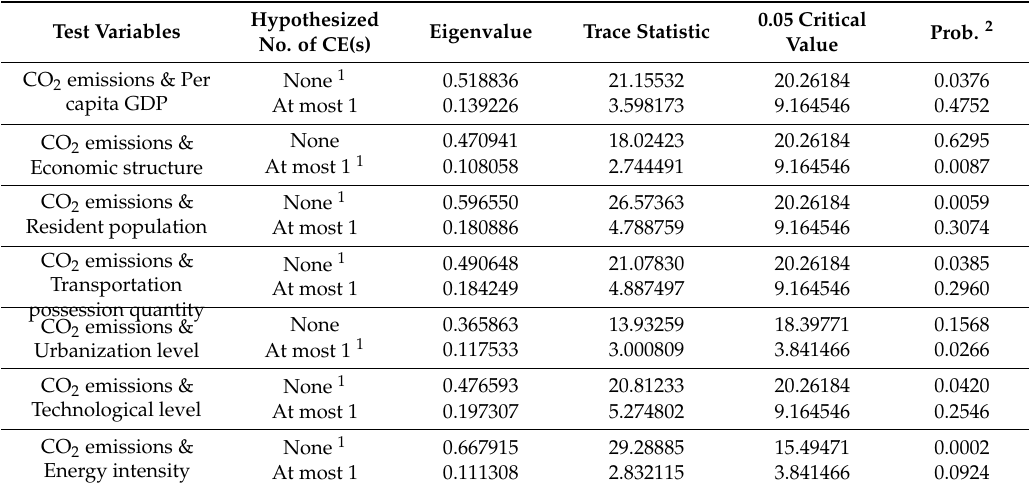
Table 2. Cointegration test results for CO 2 emissions and pre-selection